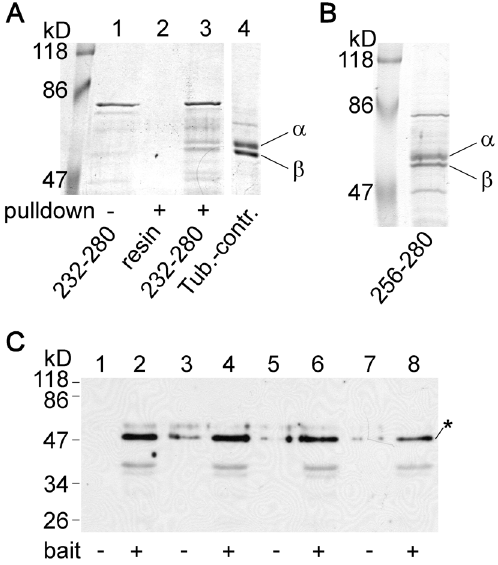
Figure 7. Tubulin interacting with the cytoplasmic loop of TRESK migrates as a double band on SDTHS-PAGE gel. A. The proteins from the pull-down assay with fragment 232–280 of human TRESK were analyzed by SDS-PAGE in the presence of STS and SHS. Under these special conditions, the band split into a doublet of a and b tubulins ( lane 3 ), although the same protein migrated as a single band on normal SDS-PAGE gels (see in Fig. 3.B lane 5 or Fig. 3.C. lane 4 ). The double band could be detected neither in the bait protein preparation ( lane 1 ) nor in the control pull-down assay with glutathione agarose ( lane 2 ). B. Similar splitting of the band was observed on SDTHS-PAGE gels in the case of tubulin pulled down with fragment 256–280 of human TRESK. C. Western blot experiment with monoclonal anti- tubulin b 3 antibody was performed from four pairs of independent pull-down assays. The analyzed proteins were pulled down from mouse brain cytosol with the GST fusion protein containing residues 174–280 of human TRESK ( even lanes, bait + ) or with glutathione agarose ( odd lanes, bait 2 ). The anti-tubulin b 3 antibody specifically labeled the tubulin bands (indicated with an asterisk ). Densitometry and statistical analysis were performed as detailed in Fig. S3. this loop [28,50]. The three regulatory serines, thought to be responsible for the inhibition of TRESK [29], are concentrated at the C-terminal end of the loop, adjacent to the third transmem- brane segment, within the RSNSCPELVLGRLSYSIISNLDE sequence. The first ( underlined ) regulatory serine in this sequence is phosphorylated by PKA and binds 14-3-3 both in vitro and in Xenopus oocytes [29,30]. We have recently reported that microtu- bule-affinity regulating kinases (MARK kinases) phosphorylate the second and/or third ( underlined ) inhibitory serines in mouse TRESK sequence, RSNSCPELVLGRLSCSILSNLDE, in vitro .